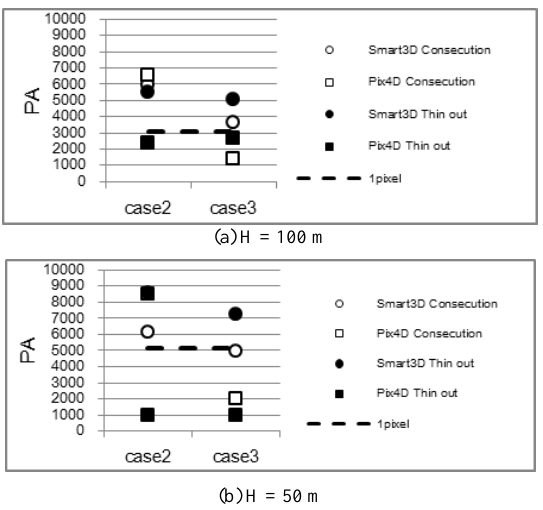
Figure 4. Relationship between number of images and